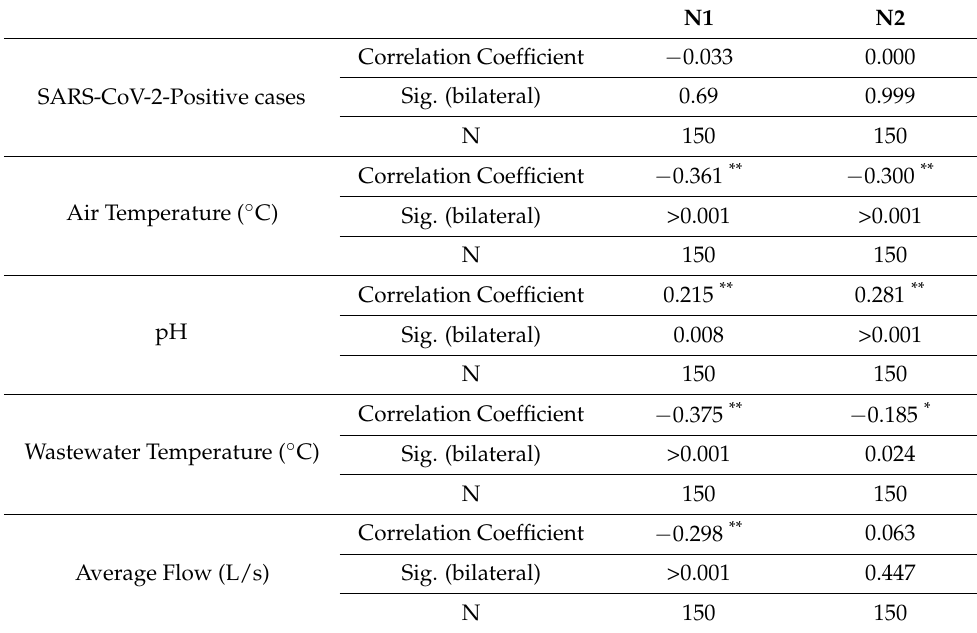
Table 2. Spearman non-parametric correlation of environmental and wastewater parameters and SARS-CoV-2 N1 and N2 targets. Correlation coefficients: high—R > = 0.6; modest—0.3 < R < 0.6; low—R < 0.3 [46,47].